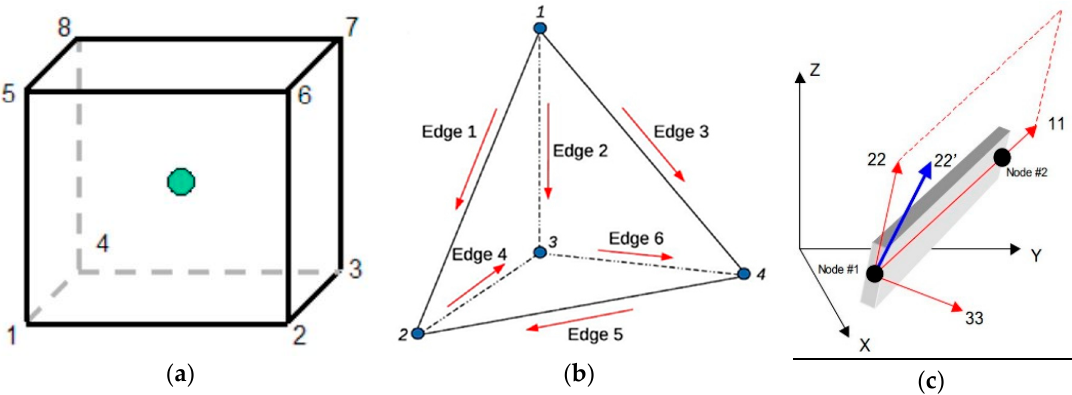
Figure 2. ( a ) “Hexahedral Solid Elements”; ( b ) “Tetrahedral Solid Elements” and ( c ) “Beam (Line) Elements”.